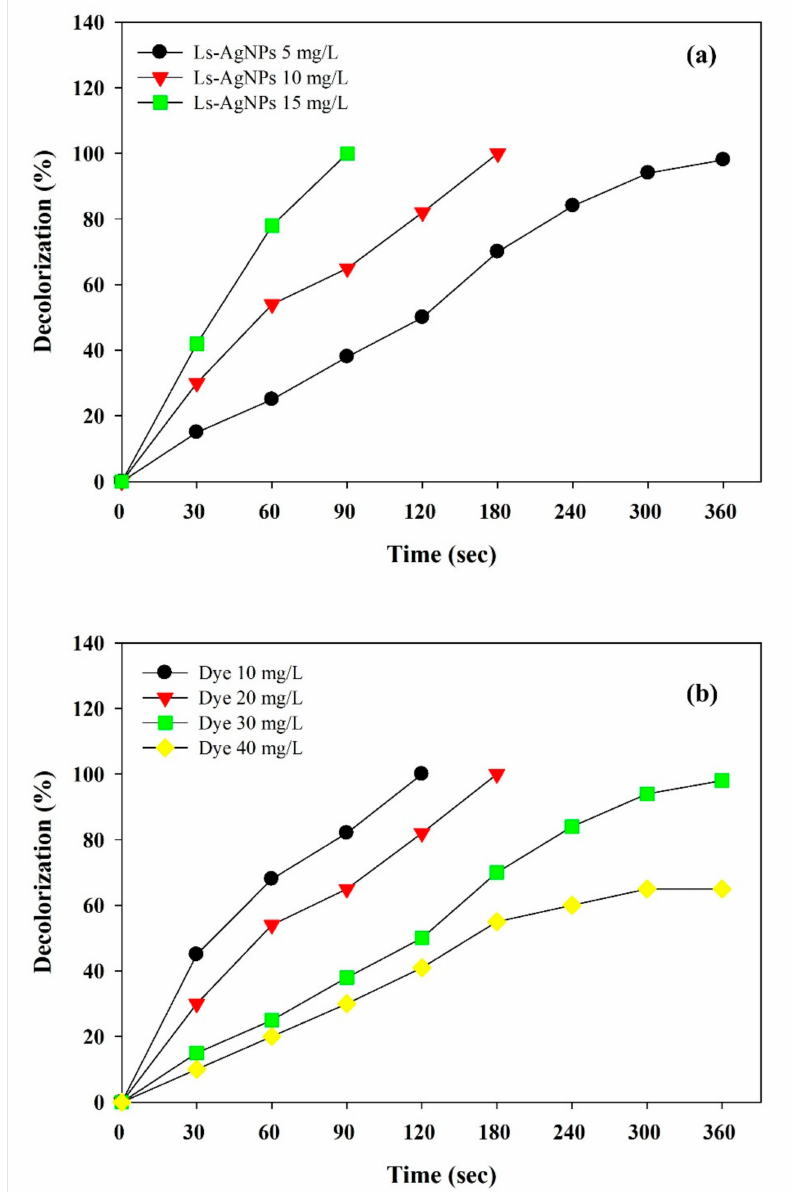
Figure 8. Effects of increasing ( a ) photocatalyst dosage and ( b ) dye concentration on the pho- tocatalytic degradation of Reactive Yellow 4G by developed LS–Ag NPs + H 2 O 2 system under UV-light